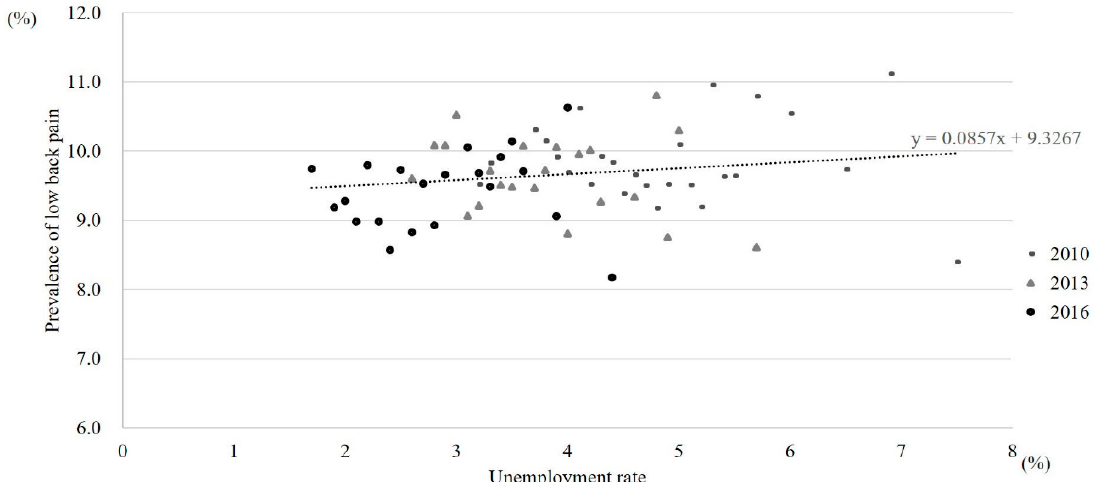
Figure 2. Prevalence of lower back pain and unemployment rate stratified by year of investigation. Each dot represents each prefecture.